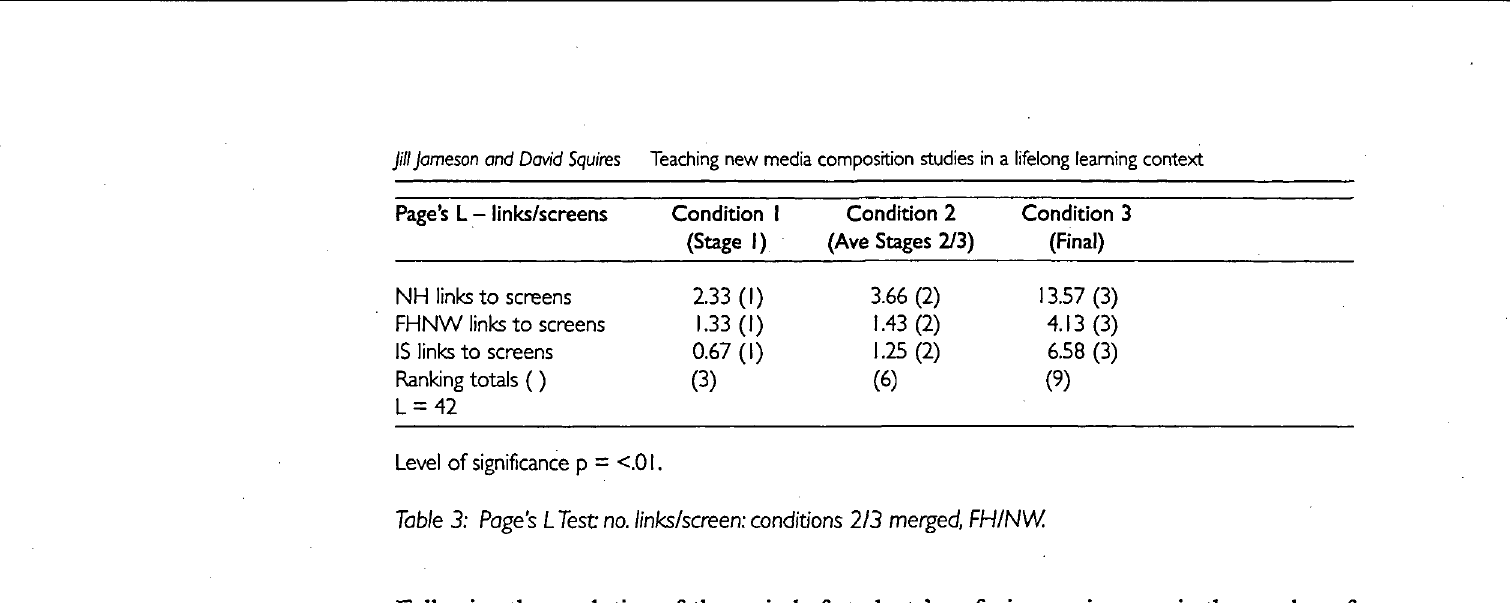
Table 3: Page's L Test no. links/screen: conditions 2/3 merged,